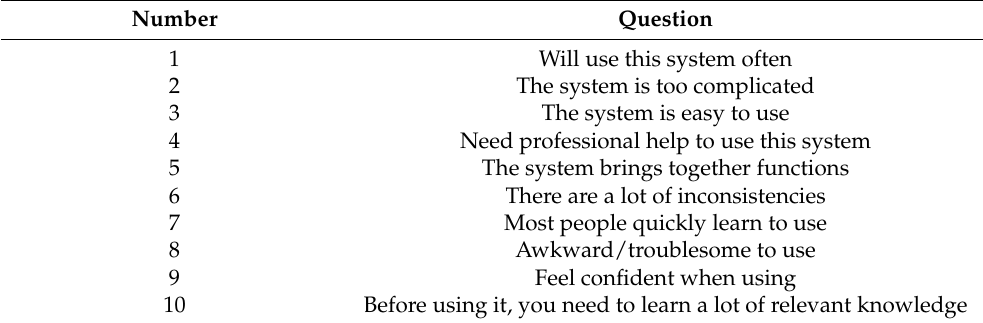
Table 4. Questionnaire contents.